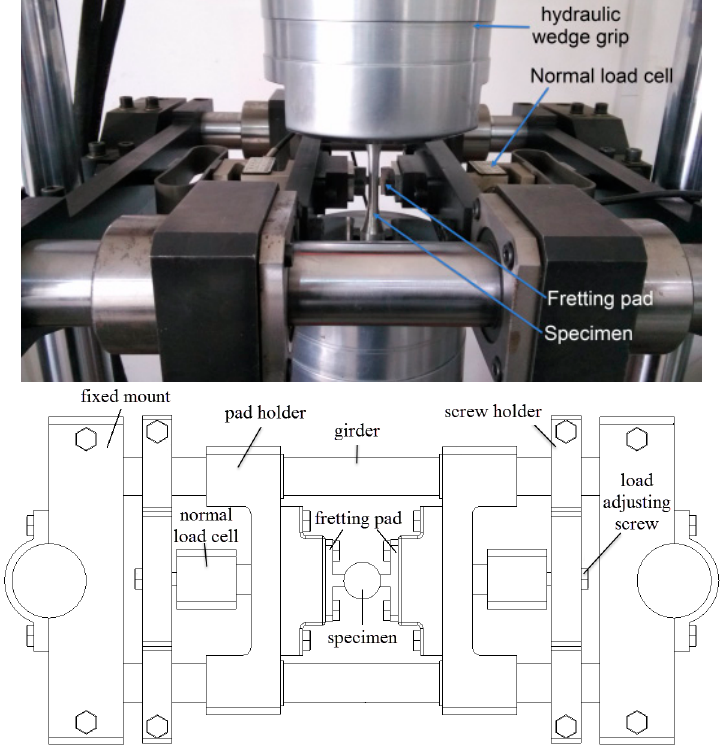
Figure 1. A schematic of the fretting fatigue test fixture.